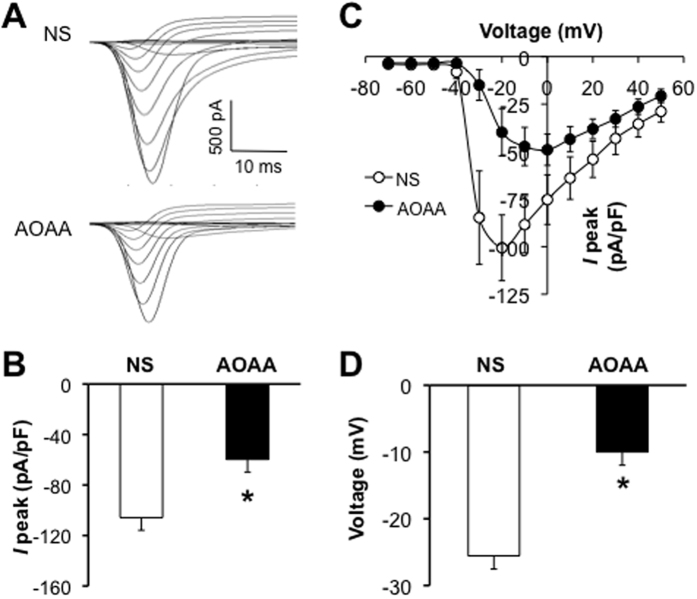
Inhibition of CBS by AOAA suppressed sodium current densities.(A) The total voltage-gated Na+ currents recorded from NS (top) and AOAA group (bottom). The membrane potential was held at −60 mV and voltage steps were from −70 mV to +50 mV with 10 mV increment and 80 ms in duration. (B) Bar graphs showed the mean peak current densities of sodium current from NS and AOAA group. The current density (in pA/pF) was calculated by dividing the current amplitude by cell membrane capacitance. The current density of DiI-labeled neurons from AOAA group was significantly decreased when compared with NS group (NS: −105.8 ± 18.1 pA/pF, n = 9; AOAA: −59.7 ± 9.8 pA/pF, n = 11, *p < 0.05). (C) Current vs. Voltage (I-V) curves were plotted from the all recorded cells. AOAA treatment did not alter the reversal potentials of total NaV currents. (D) Bar graphs showed that the membrane voltage, at which the current was maximally activated, was significantly depolarized in AOAA group when compared with NS group (NS, −25.6 ± 2.4 mV, n = 9; AOAA, −10 ± 4.9 mV, n = 11, *p < 0.05).